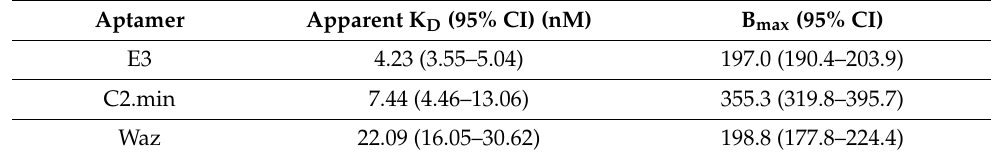
Table 1. Binding constants from data collected in Figure 1b and Supplementary Figure